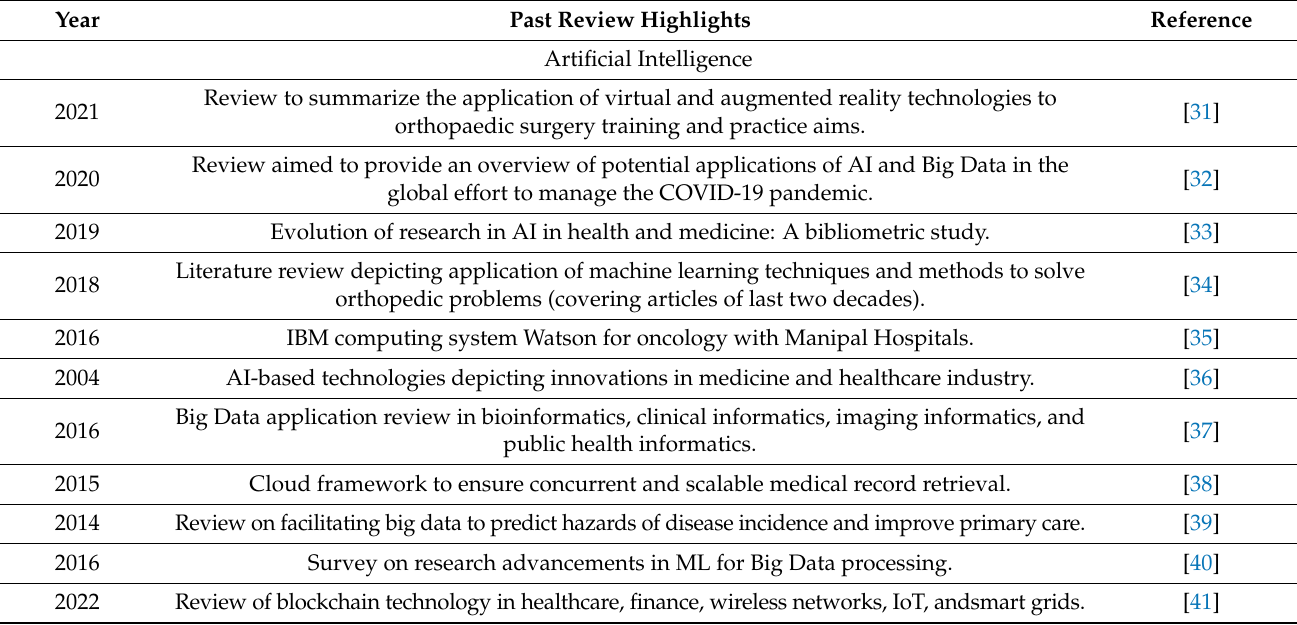
Table 1. Past review highlights of various technologies for healthcare